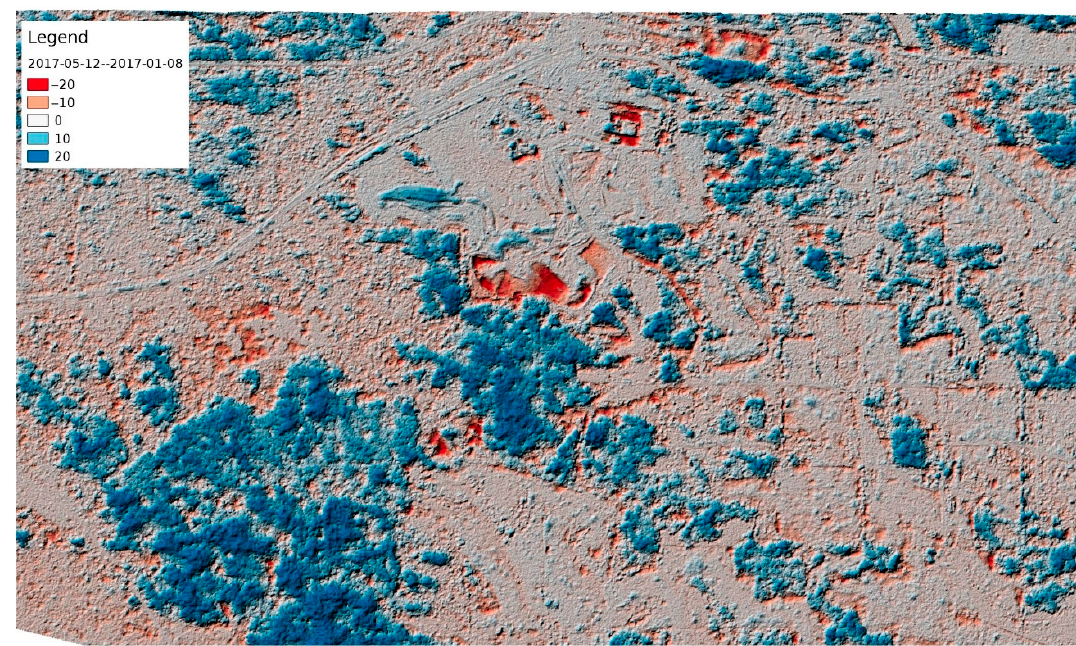
Figure 16. Image showing difference between January and May DSMs for an area in Wisconsin.